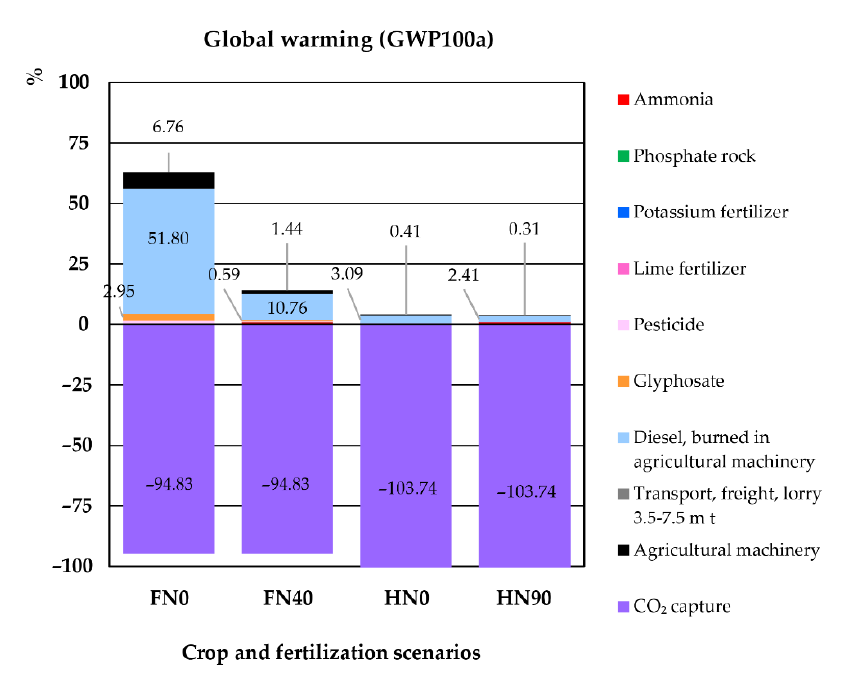
Figure 5. CML2 baseline results from hemp and flax fertilization scenarios HN0, HN90, FN0, and FN40 for global warming (GWP100a) impact FN40 for global warming (GWP100a) impact category.